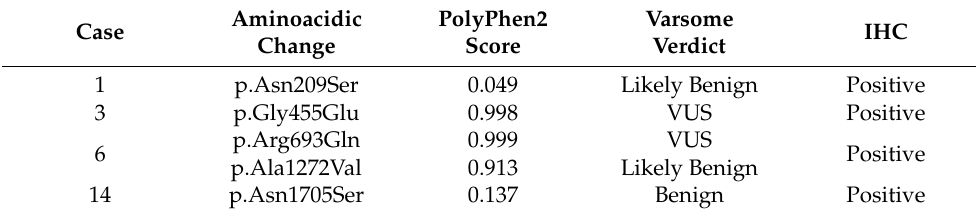
Table 3. Cases with positive ARID1A protein staining but harboring ARID1A DNA